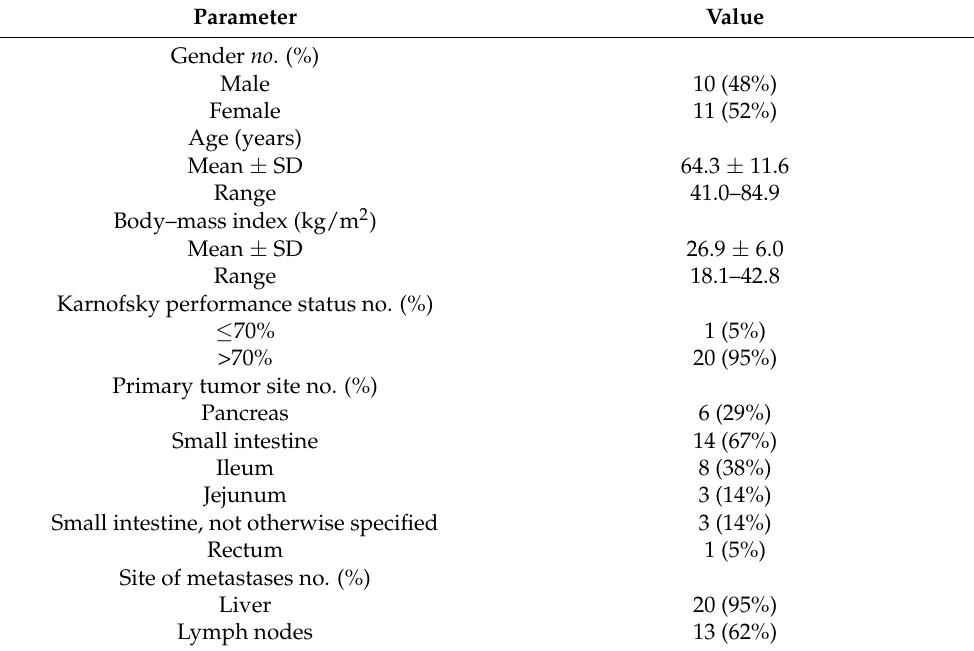
Table 1. Characteristics of study population ( n = 21).